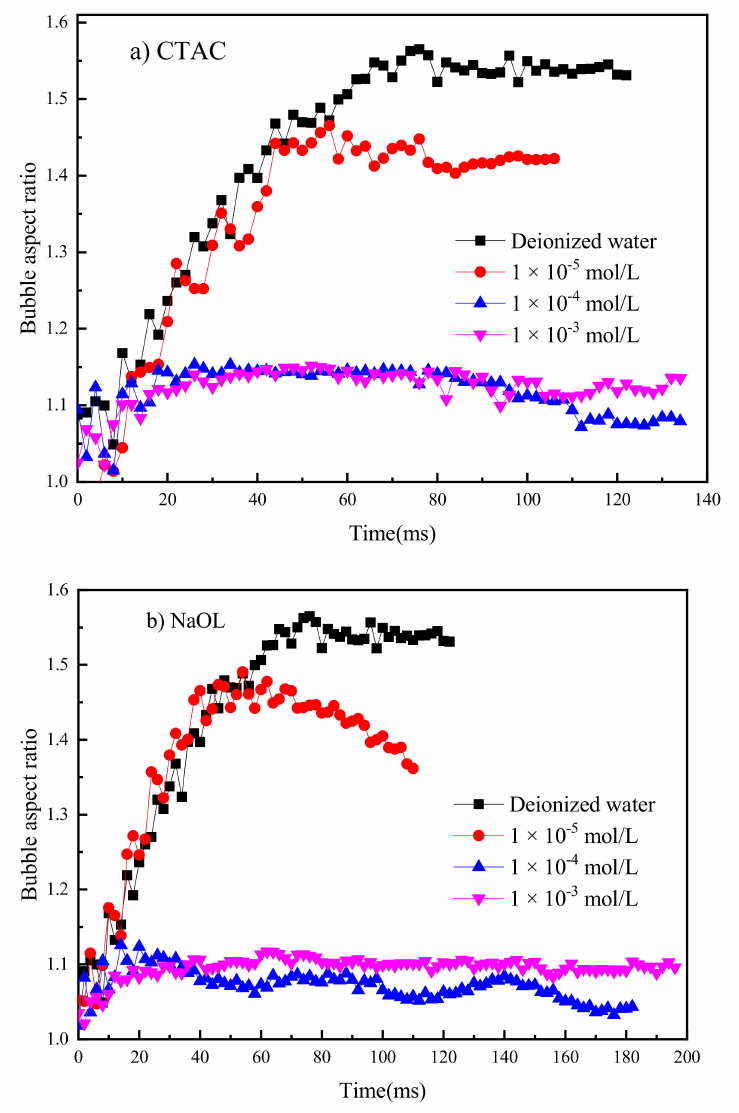
Figure 4. Bubble aspect-ratio change with time in different surfactant solutions. ( a ) CTAC; ( b ) DDA. The bubble stability in this study means its rupture time. The longer it takes for the bubble to rupture, the more stable the bubble. That is to say, the time of the bubble existence corresponds to its stability. The bubble rupture time in the CTAC and NaOL solutions was also investigated and repeated some times. The result at different times is shown in Figure